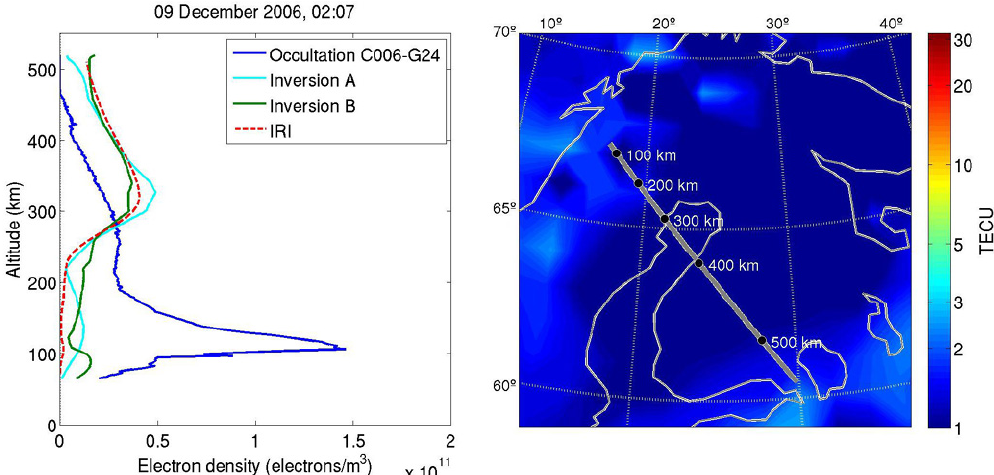
Fig. 12. Comparison between inversion result and occultation measurement, similarly as in Fig. 10, for 9 December, 02:07, between COSMIC satellite 6 and GPS satellite